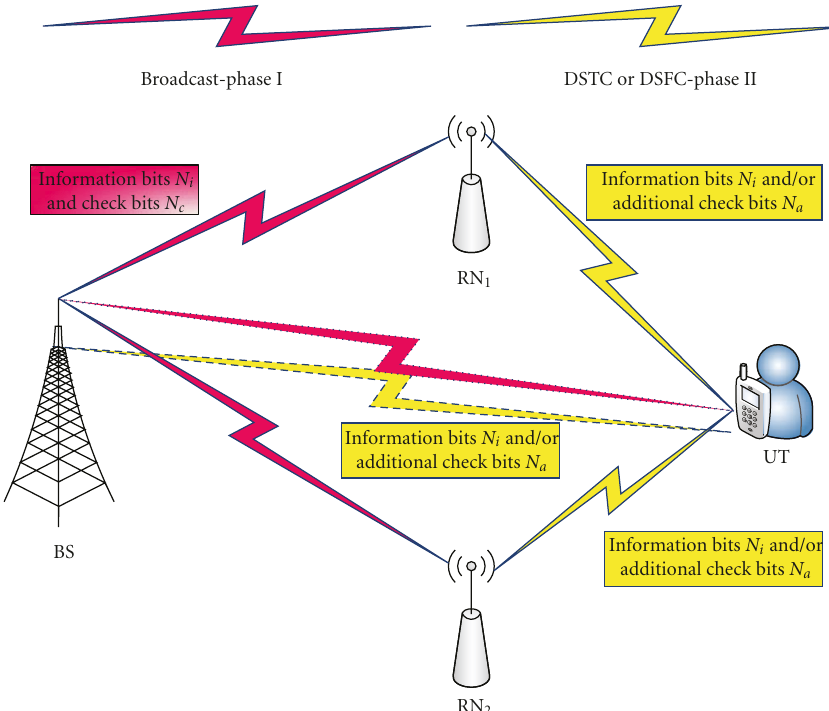
Figure 1: Topologies for DSFC-based cooperation algorithms: with two RNs (solid line); with one RN (dashed